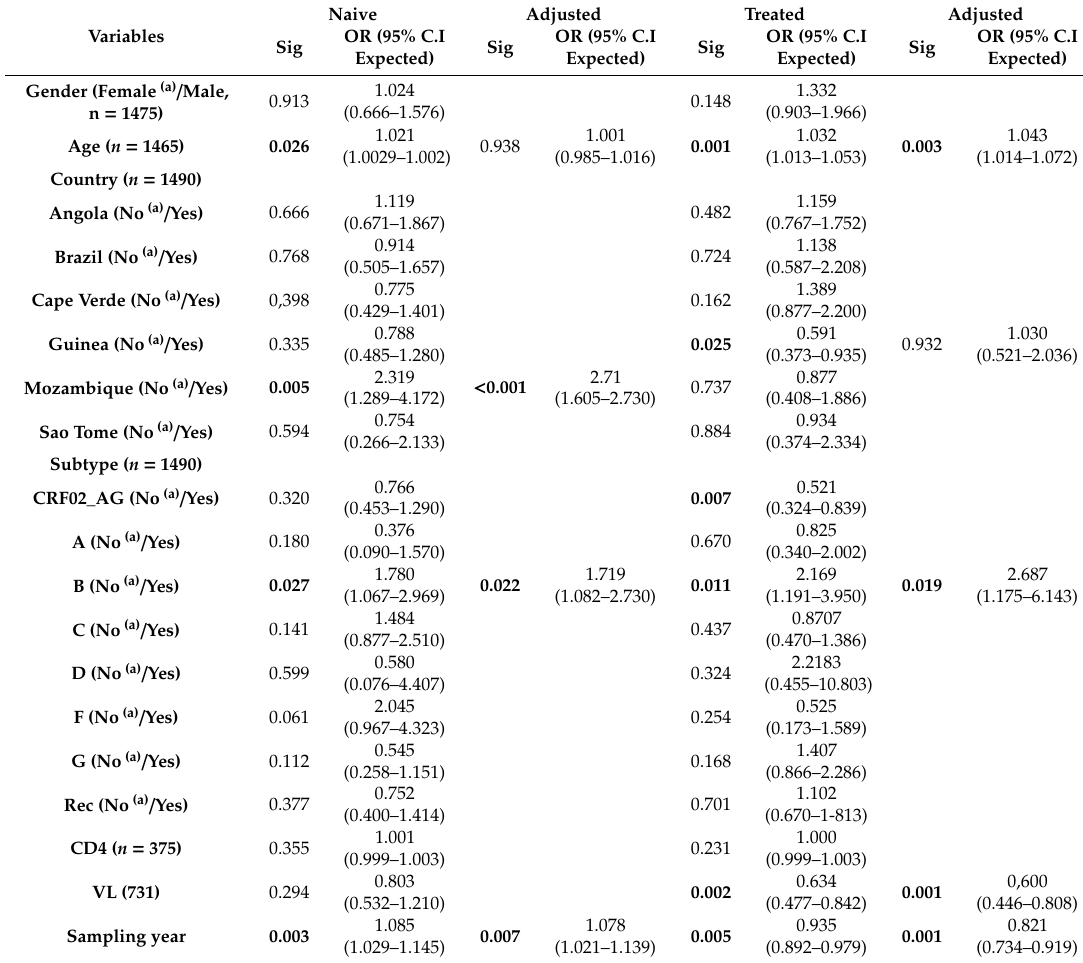
Table 4. Influence of baseline factors and treatment modification to developed Transmitted Drug Resistance (TDR) and Acquired Drug Resistance (ADR). Naive Adjusted Treated Adjusted